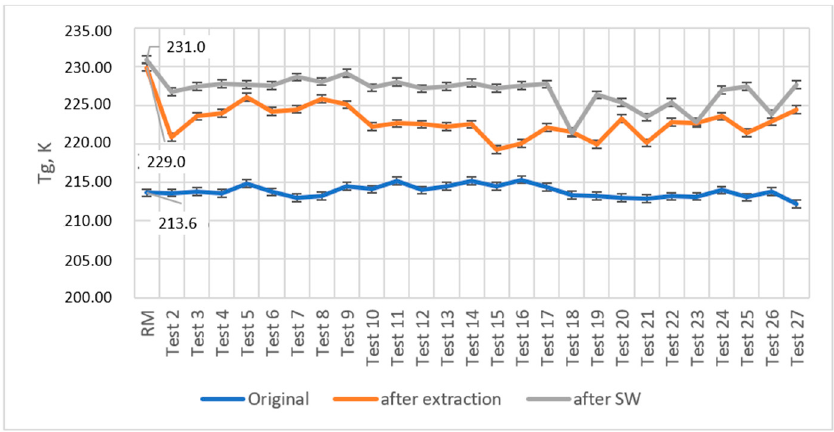
Figure 7. Tg values of original, after-extraction and after SW samples series.